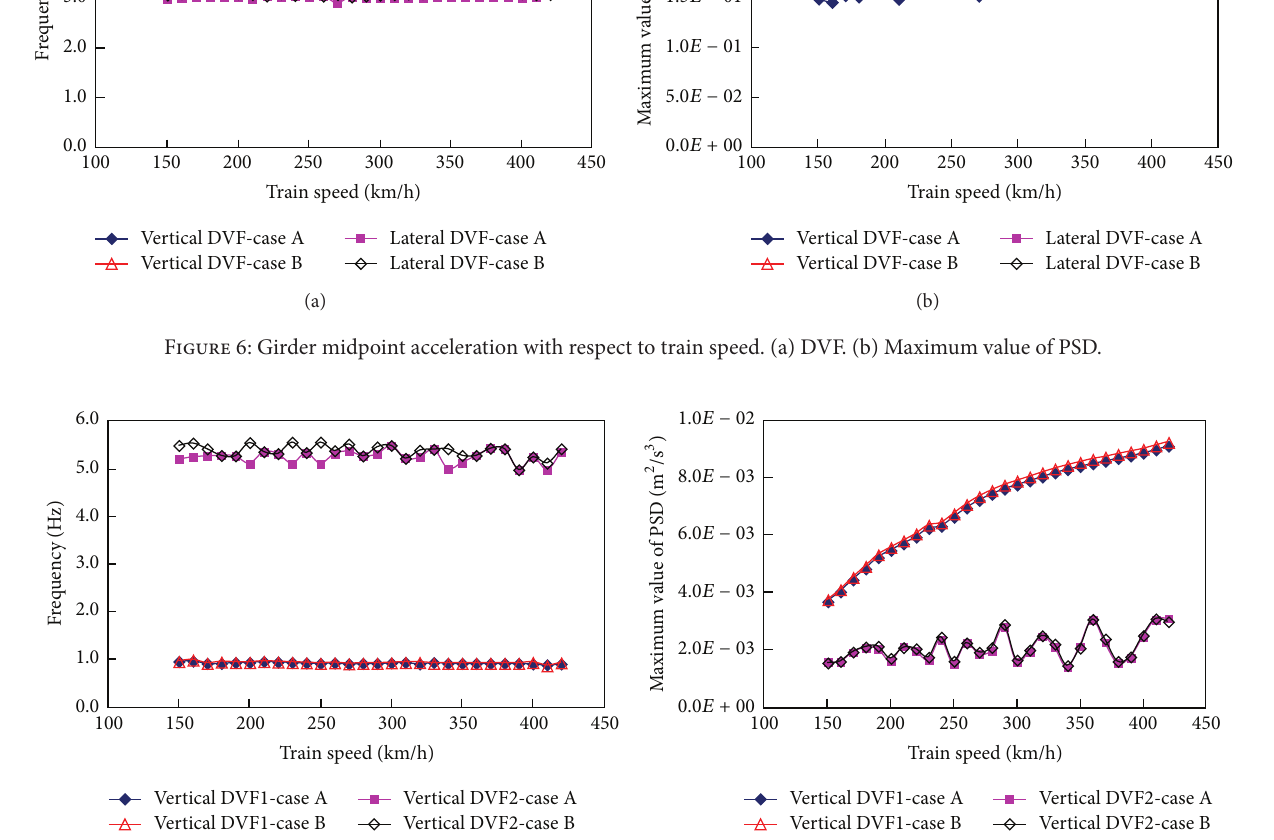
Table 3: Calculation cases for studying the influence of train speed.